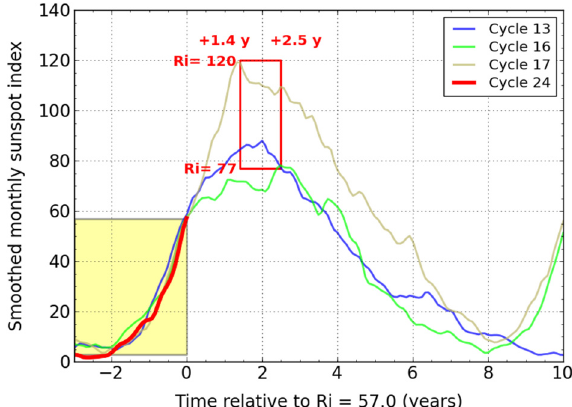
Fig. 11. Superposed-epoch plot of all the cycles since cycle 1 that best match the early rise of cycle 24 (red thick curve) over the 12 months before the July 2011 tie point (origin of the horizontal relative time axis). The overlaid red rectangle frames the ranges of amplitudes and times of maxima for all matching cycles. This gives the actual range of past cycle evolutions compatible with the current rise profile, which was rather steep in 2010–2011.